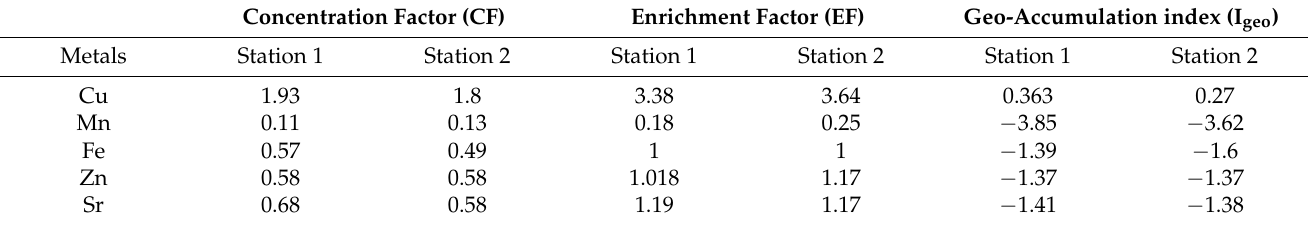
Table 2. Assessment of pollution of heavy metals in the sediment of Mongla (Station 1) and Karamjal (Station 2) mangrove